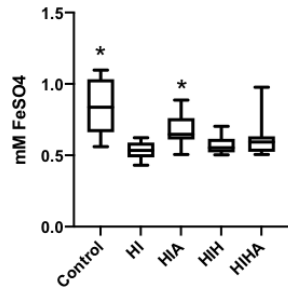
Figure 3. Box plot cerebral spinal fluid FRAP levels . C: Control, HI: Hypoxia-ischemia, HIA: Hy- poxia-ischemia + allopurinol, HIH: Hypoxia-ischemia + hypothermia, HIHA: Hypoxia-ischemia + hypothermia + allopurinol. * p < 0.05 in post-hoc analysis compared to HI.